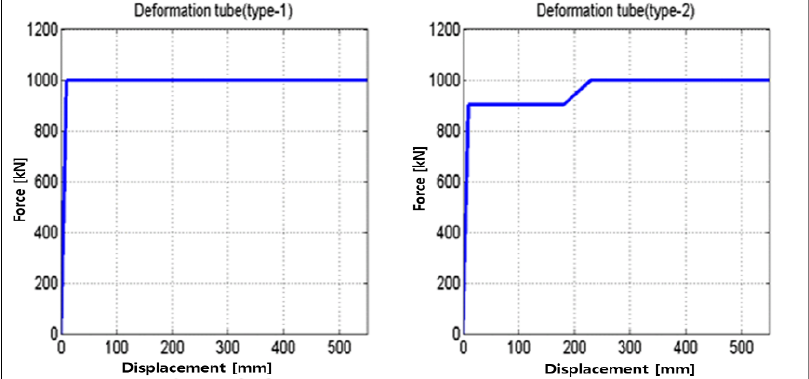
Figure 9. Typical characteristic curve of a deformation tube.